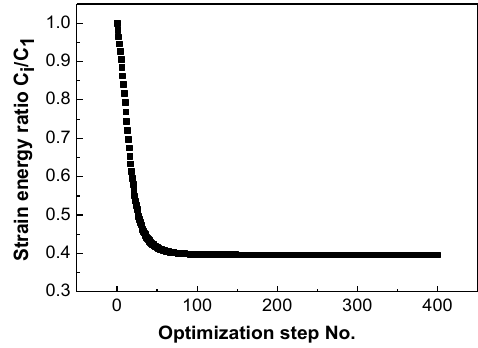
Figure 3. The convergence process of Model 1.